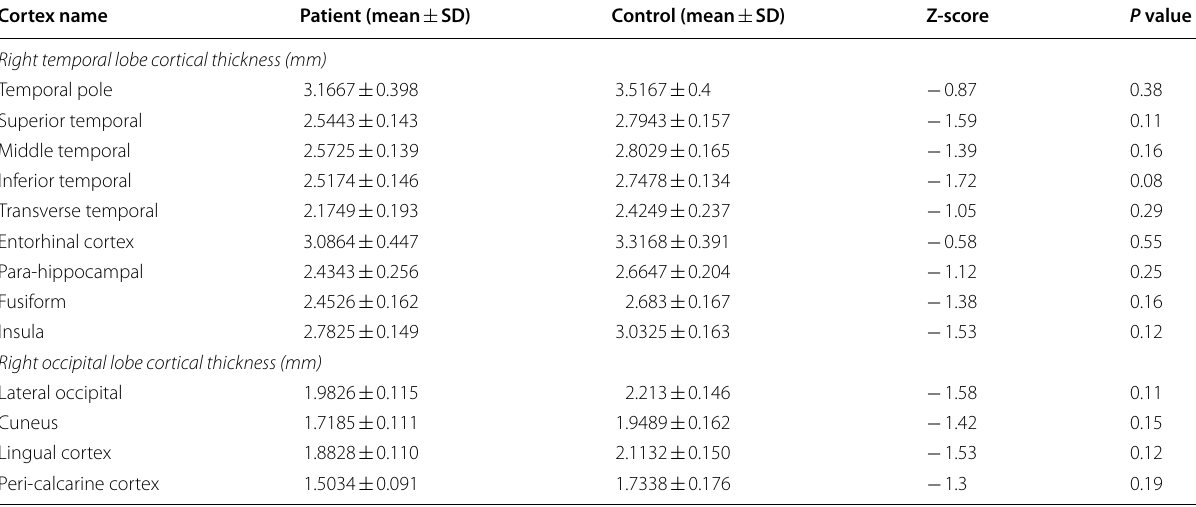
Table 6 Quantitative results of the cortical thickness in mm of the right temporal and occipital lobe areas in mm for patients and control groups, Z-scores and P